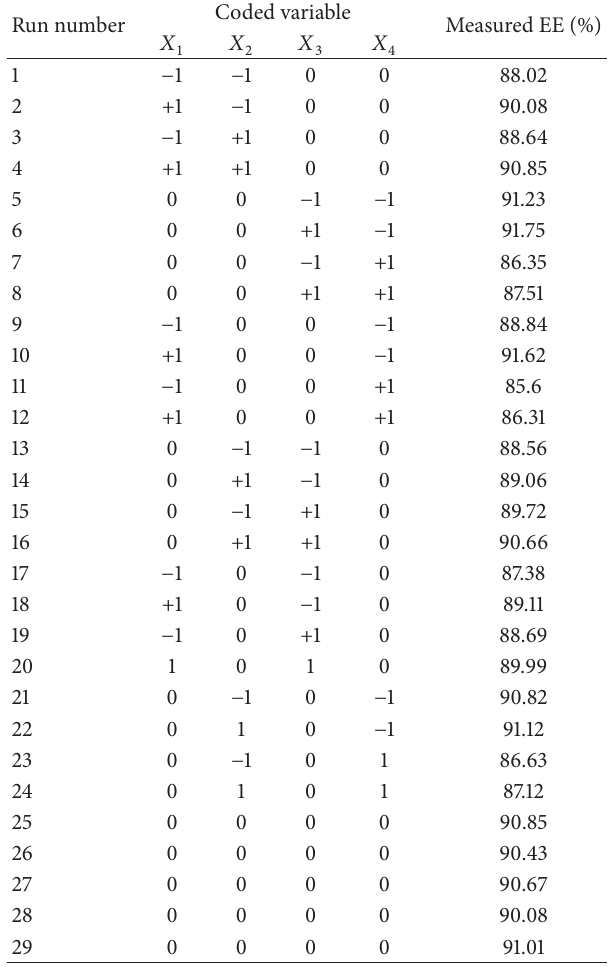
Table 1: Coded levels for independent variables used in experimen- tal design for microencapsulation of FE.